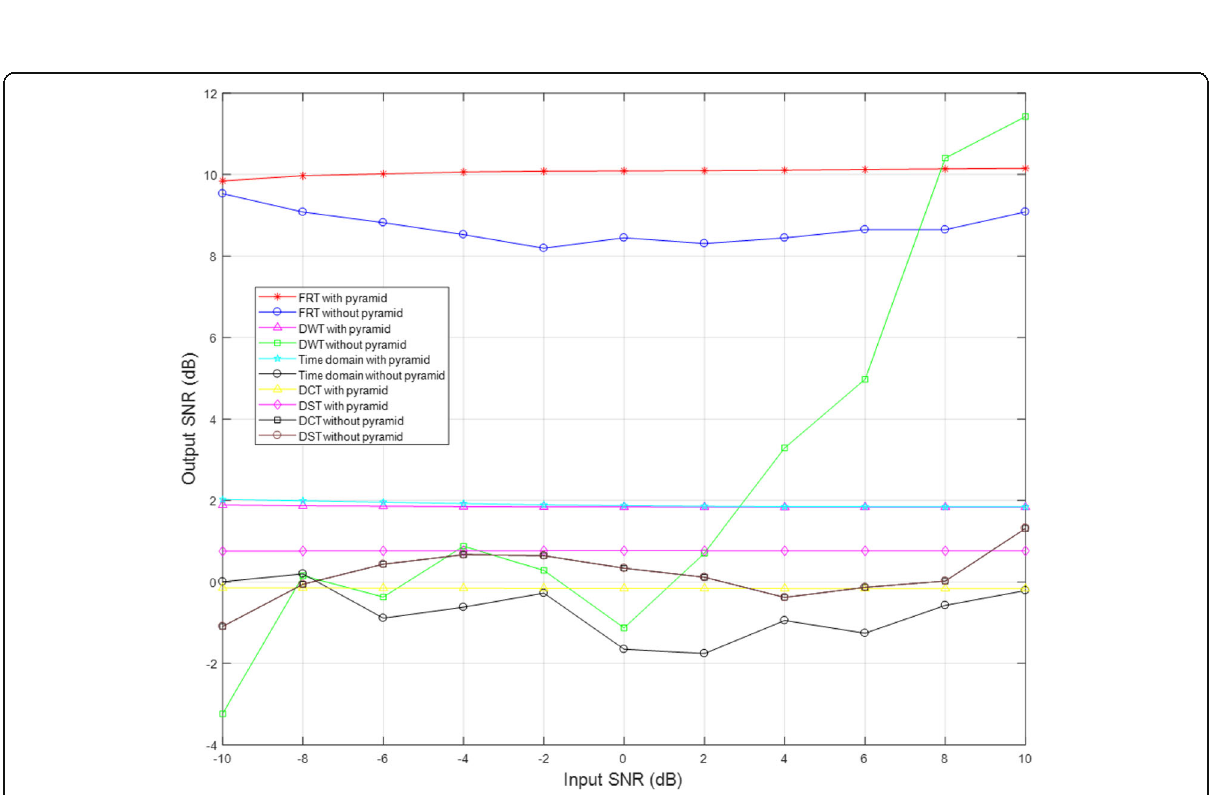
Fig. 12 Output SNR vs. input SNR for Baboon image overall separation